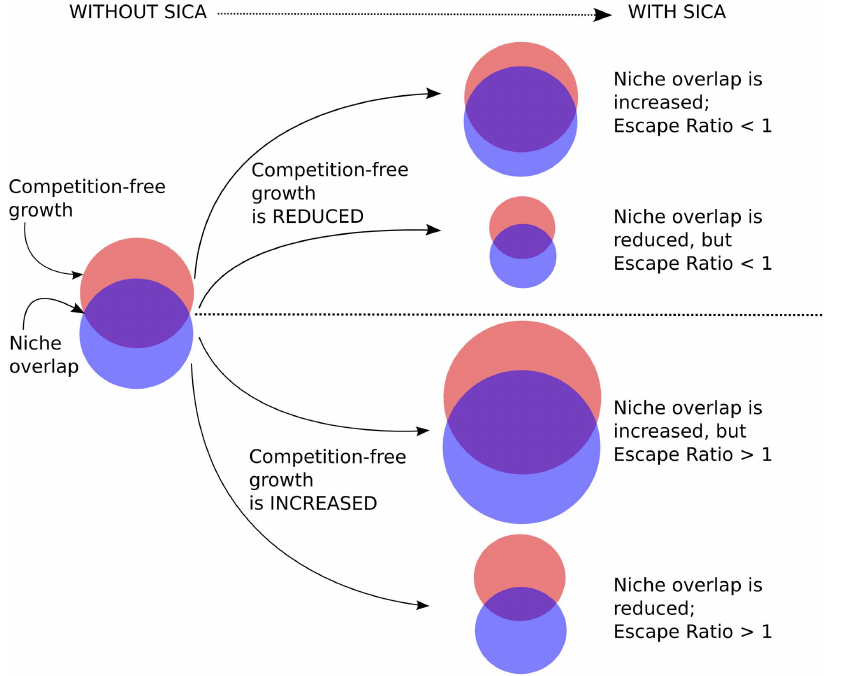
Figure 2. Characterizing Escape Ratios (ER) among competing microbes. The niche of each microbe is denoted by a shaded circle, which represents the cumulative growth of an isolate on the total suite of nutrients used by that isolate. Niche overlap is the area of intersection between the two circles, and quantifies the total growth for each isolate on nutrients used by both isolates. Competition-free growth is the non-intersecting area for each circle, or total growth for an isolate on nutrients that the competing isolate does not use. The escape ratio (ER) is the ratio of competition-free growth in the presence vs. the absence of SICA. When the escape ratio is greater than one, we hypothesize benefits to an isolate from the presence of SICA.